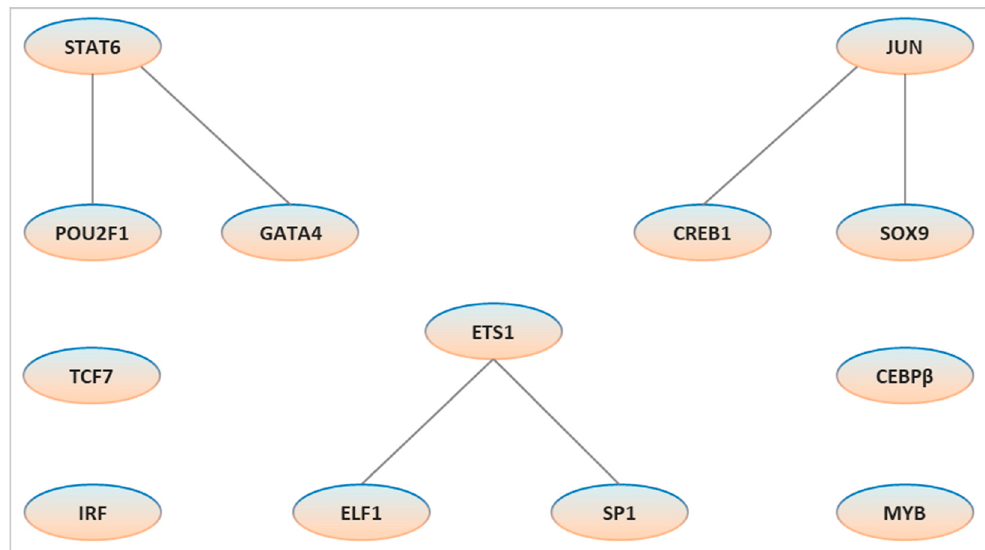
Figure 4. The significant common transcription factor pairs and their potential cooperation network for sex determination and colour pattern in zebrafish. Nodes represent the identified transcription factors for both phenotypes (sex and colour) and edges represent their potential cooperation.